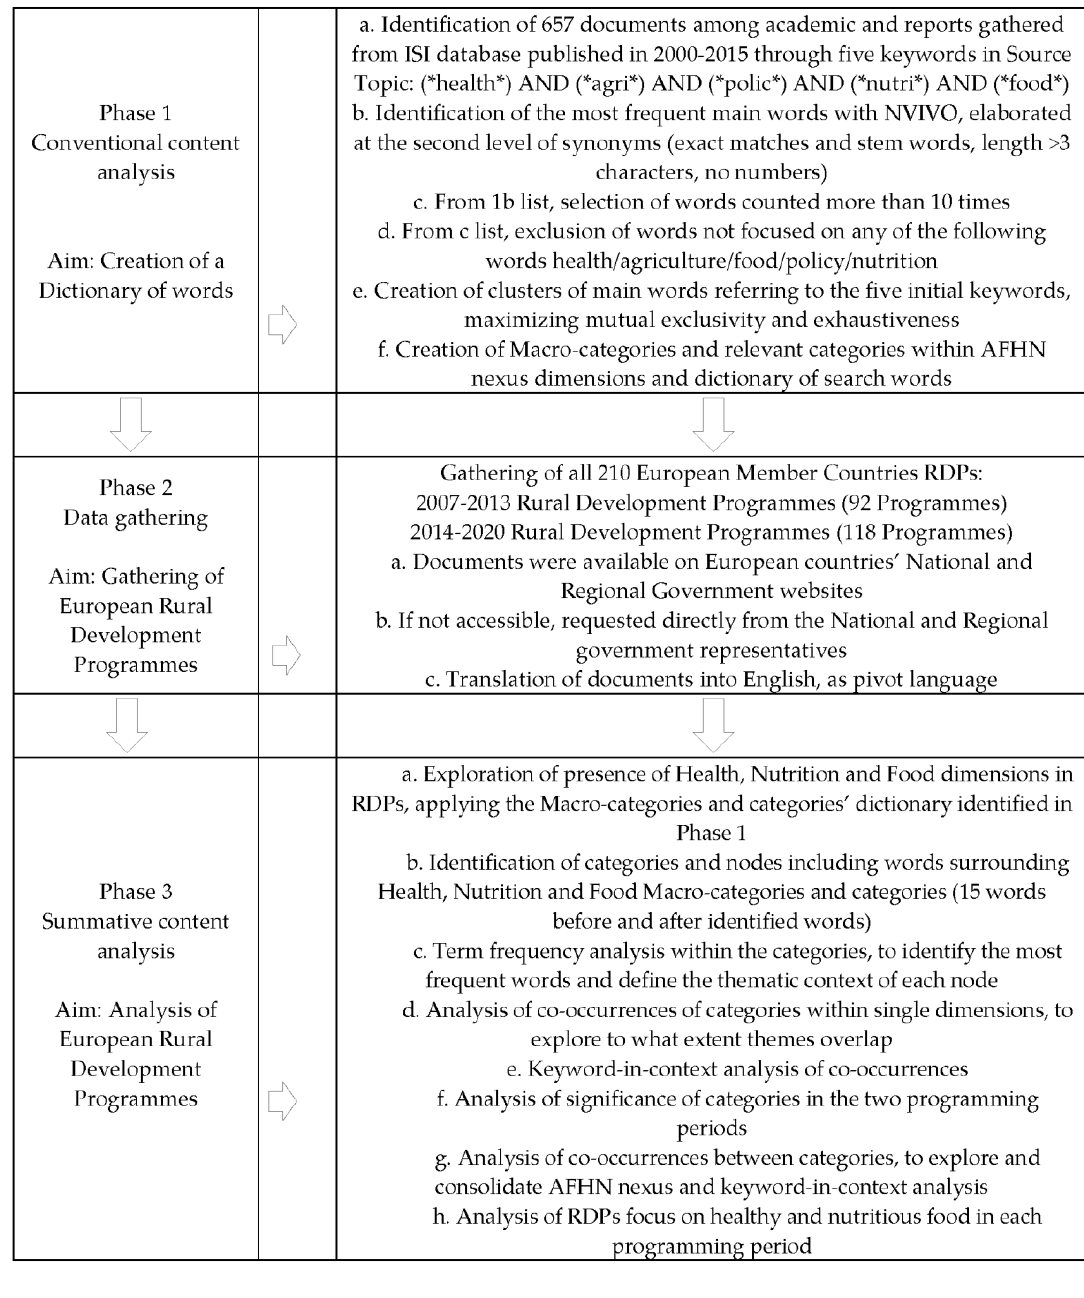
Figure 1. Research Phases.